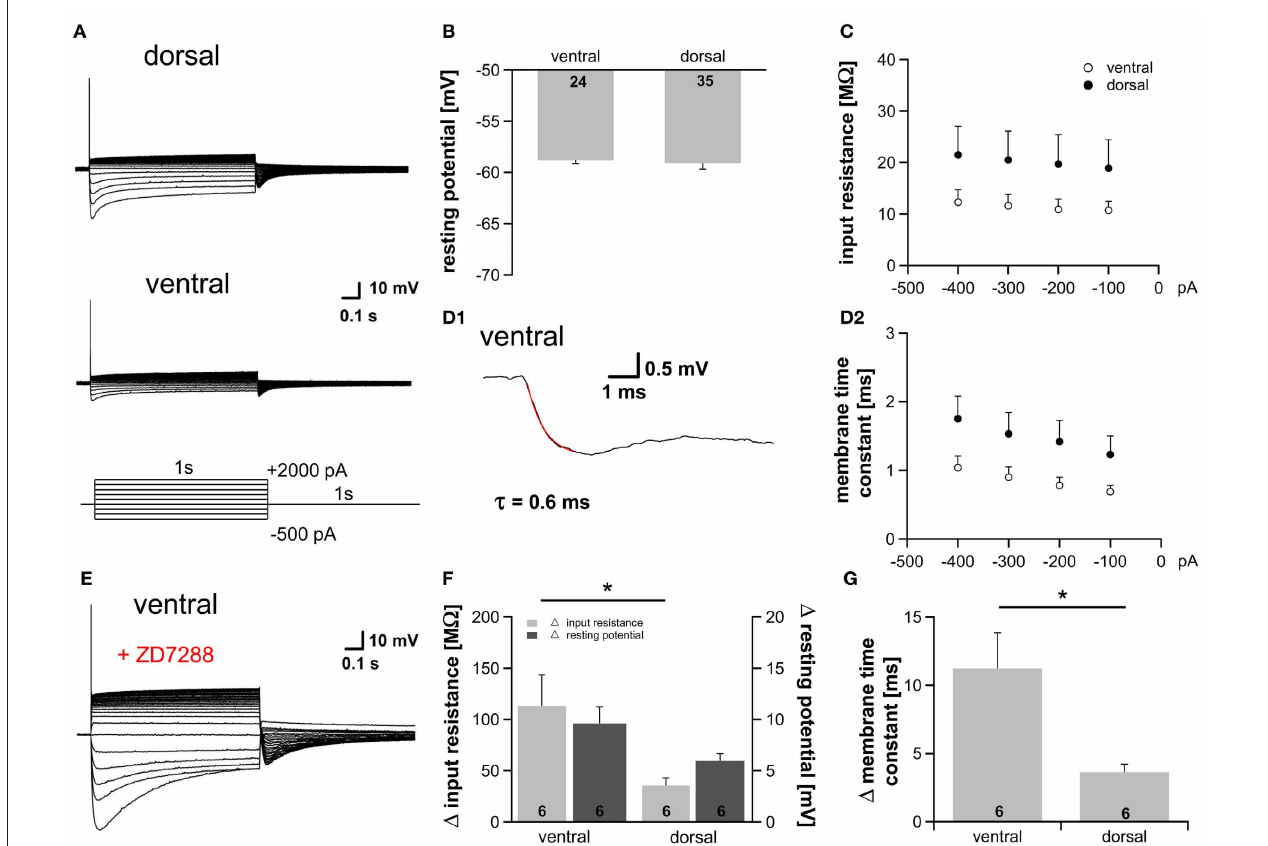
FIGURE 3 | Gradient of I h affects membrane properties. (A) MSO neurons in the dorsal and in the ventral part of the MSO fire a single spike at the onset of depolarizing current injections and exhibit a voltage sag during hyperpolarizing current steps. (B) Resting membrane potential, (C) peak input resistance, and (D) membrane time constant are not significantly different between ventral ( n = 18) and dorsal ( n = 25) neurons (D2) . The membrane time constant was fitted by a single-exponential function as shown in (D1) . (E) Blocking I h with 20 μ M ZD7288, a specific I h blocker, hyperpolarizes the